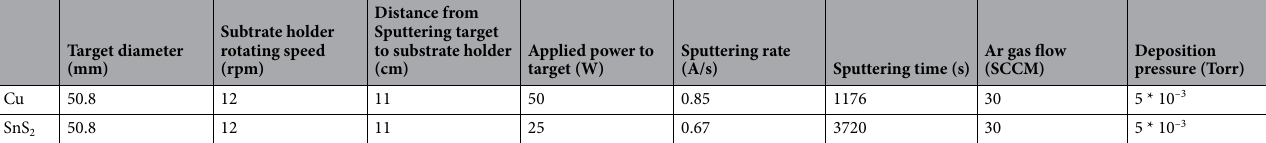
Table 3. Deposition